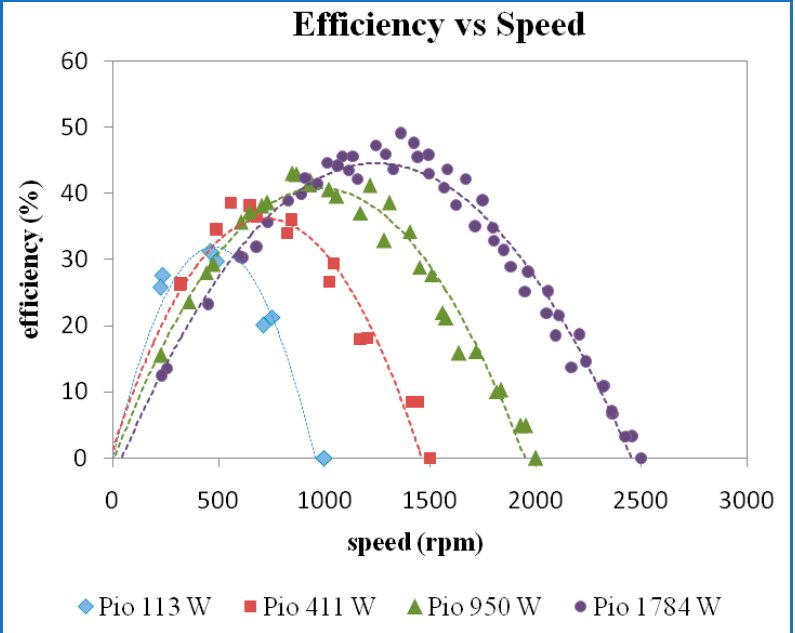
Figure 18. Efficiency vs. speed at a guide vane opening of 16 mm. From Figure 19, it is seen that at 113 W power input, the discharge was constant. At other input power, the discharge was slightly decreased as speed increased at 16 mm GVO. The iso-efficiency lines plotted seem to be a straight line with different slopes. The discharge versus speed at BEP is 32%, 38%, 42%, and